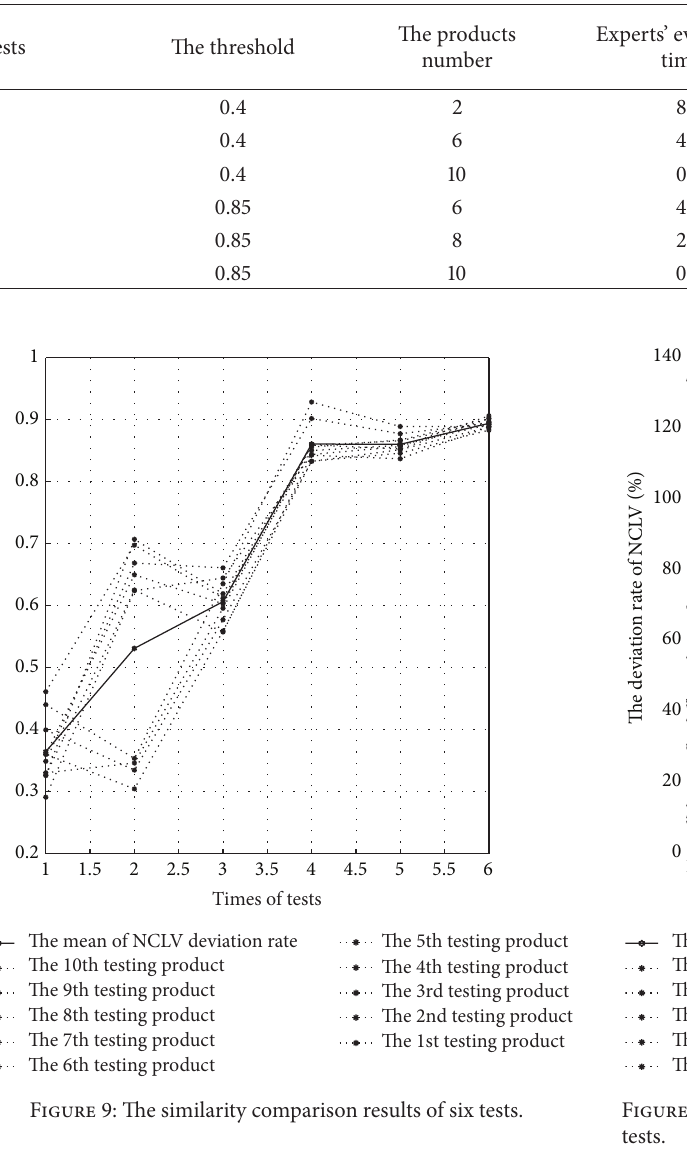
Table 2: The verified results of the validity of C&M-CVPM.